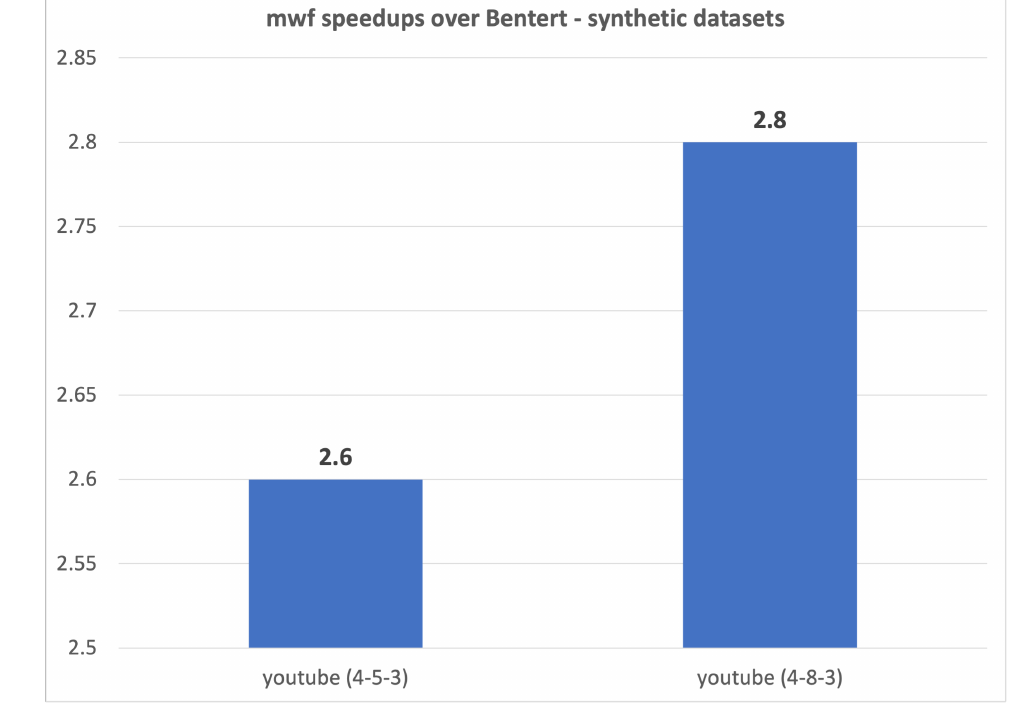
Figure 16. mwf speedups on synthetic